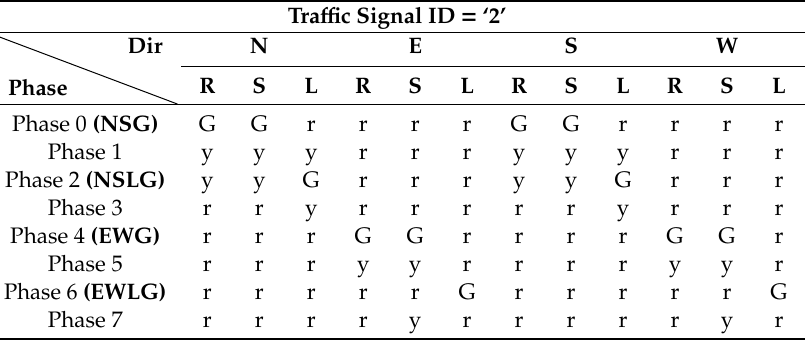
Table 1. The example of tra ffi c signal system at single